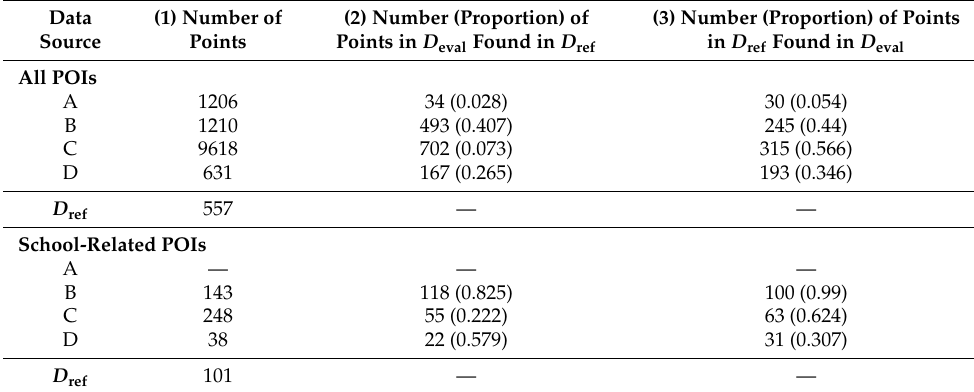
Table 2. Results for completeness across all POI place types and a subset of school-related